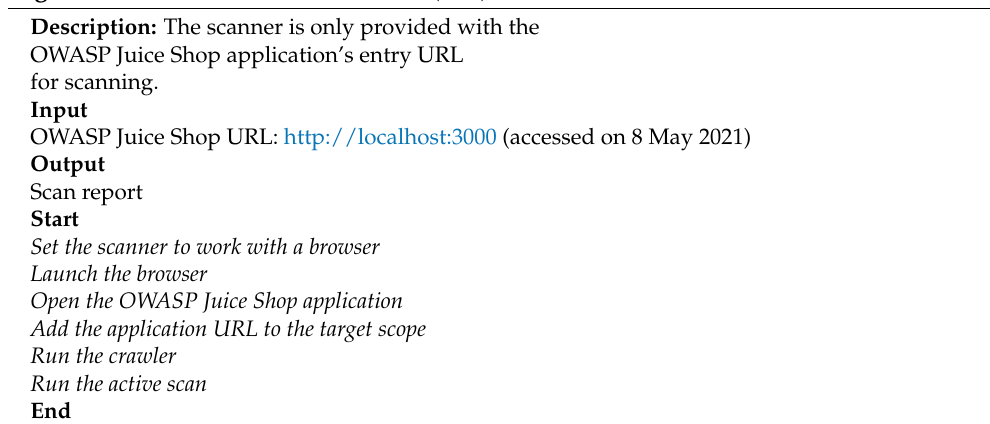
Algorithm 1 Mode 1: Point-and-shoot